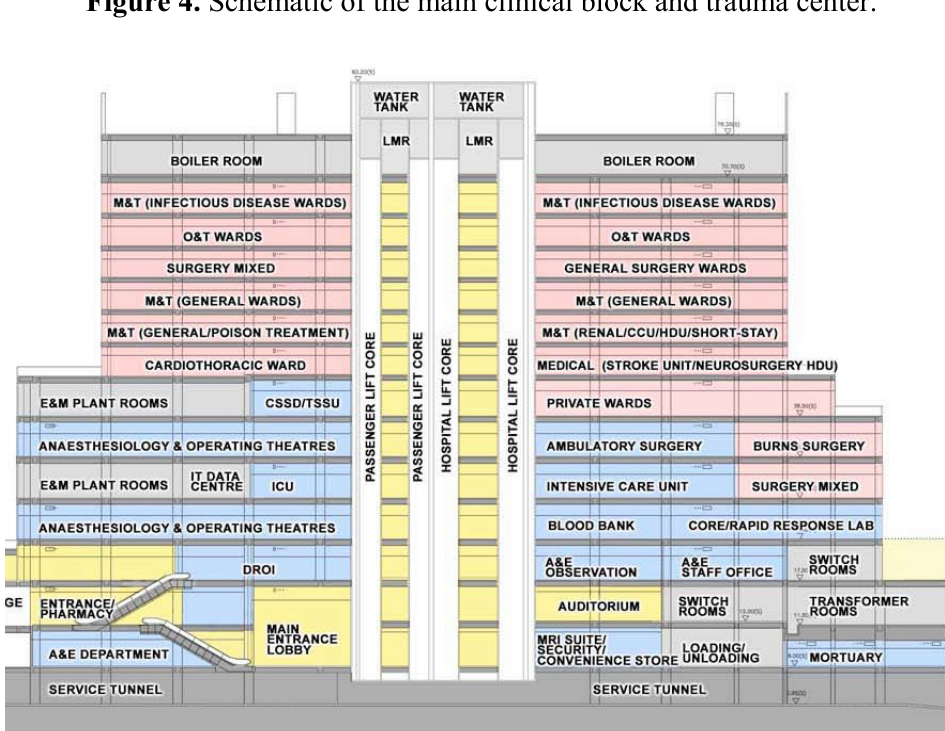
Figure 4. Schematic of the main clinical block and trauma